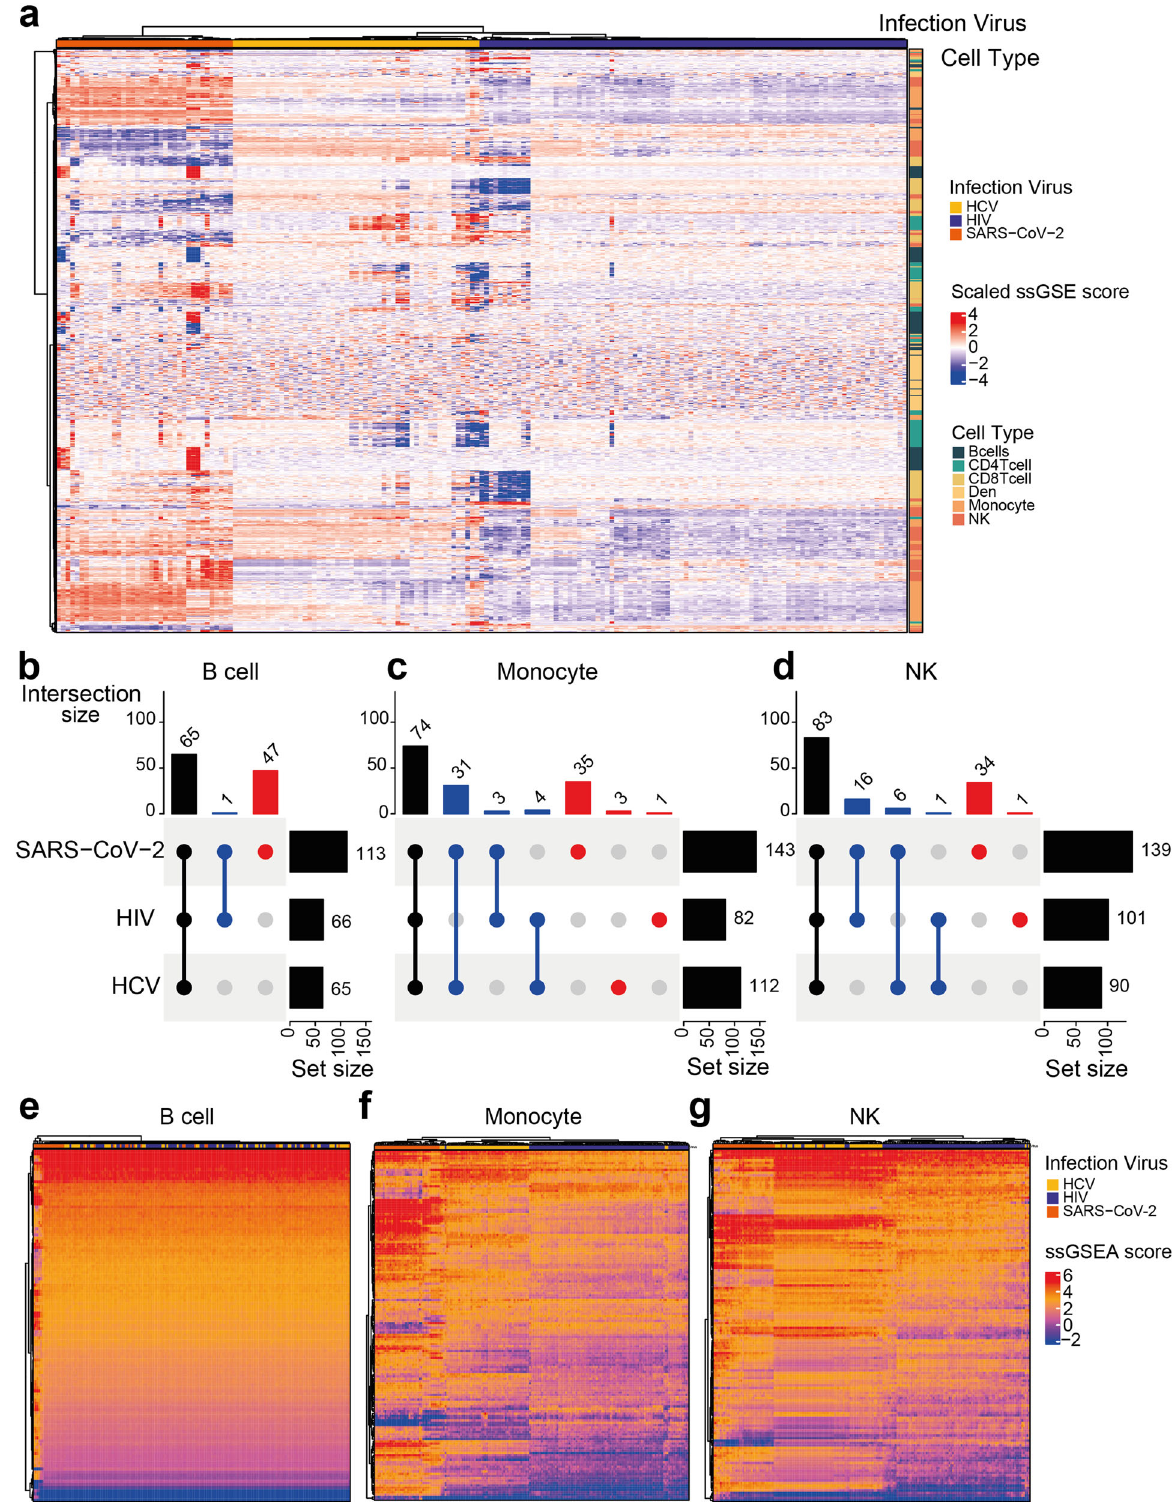
Fig.5|Functionenrichmentofcell-speci fi cGEP.a Heatmapofenrichmentscores for various cell types, including B cells, CD4 T cells, CD8 T cells, Dendritic cells, Monocytes, and NK cells within different virus infection samples. The enrichment scoreshavebeenscaledbythe Z -score.Thetoprowannotationrepresentsthevirus types of the infection. The left column annotation represents the corresponding